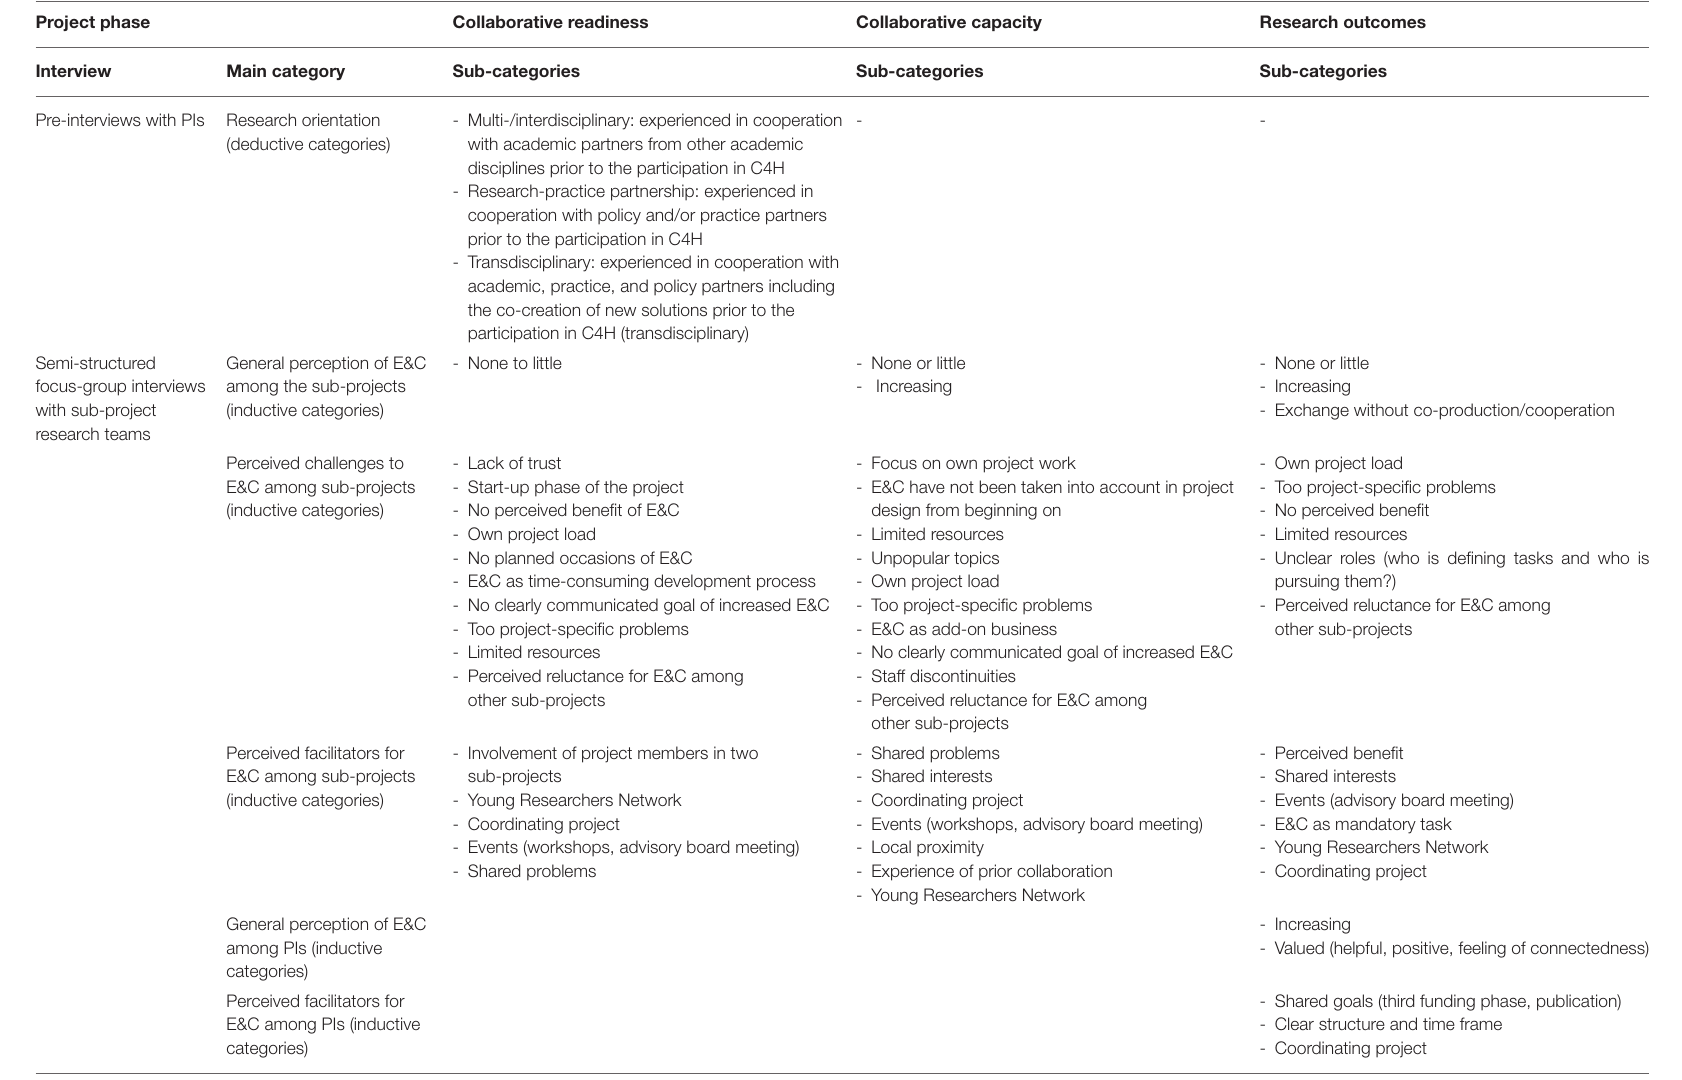
TABLE 2 | Category system for pre-interviews and semi-structured focus-group